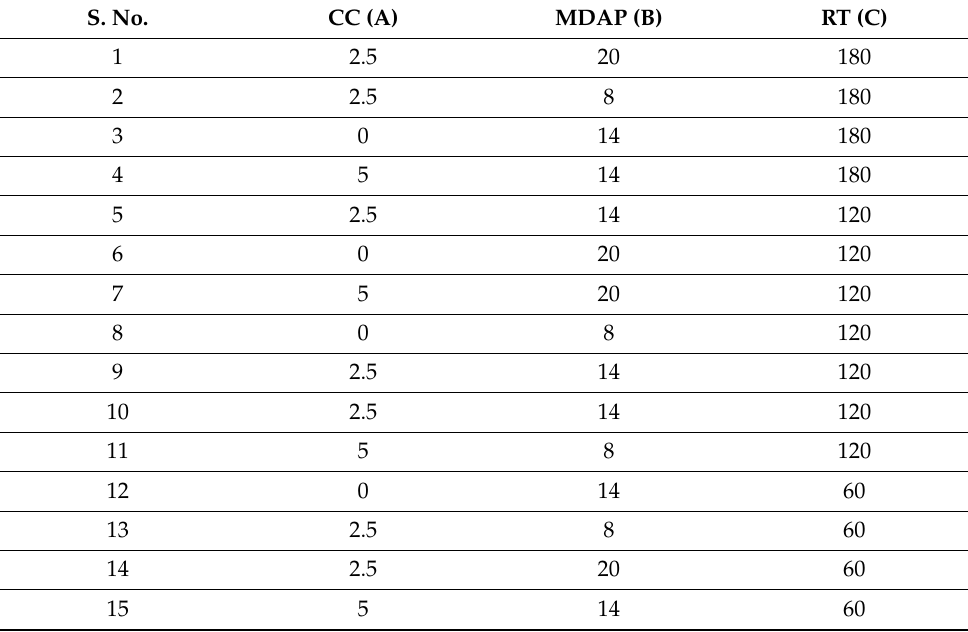
Table 1. Design of experiments for optimization studies considering different parameters. S. No.